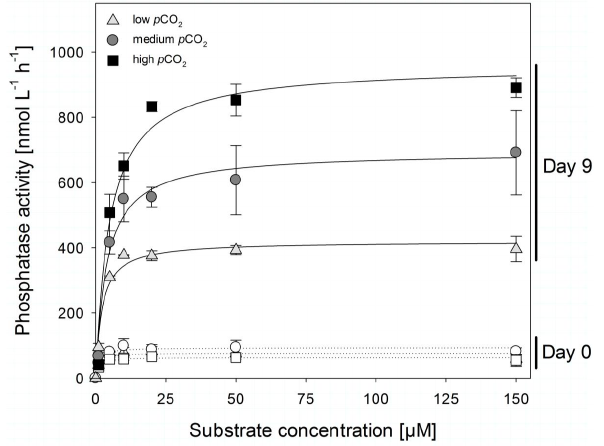
Fig. 6. Total alkaline phosphatase activity at day 0 and day 9 of low (triangle), medium (circle) and high (square) p CO 2 treatments. Symbols display the mean of three replicates with standard devia- tion.